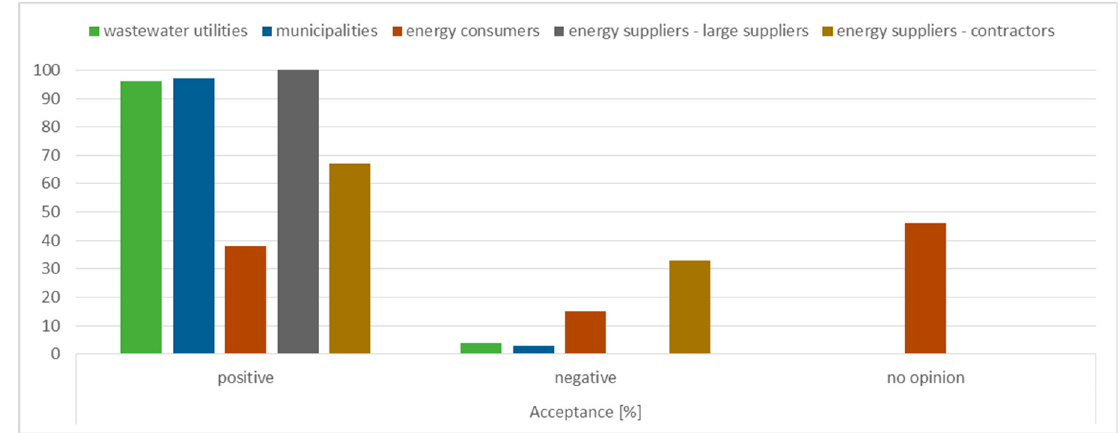
Figure 4. Acceptance concerning the energetic use of wastewater.